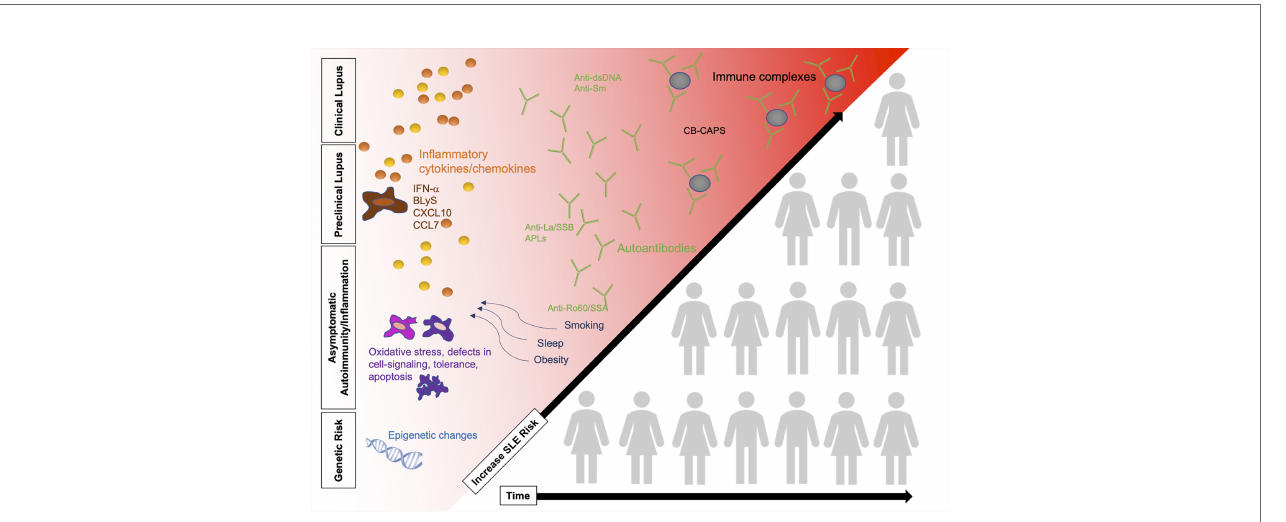
FIGURE 1 | SLE pathogenesis in four phases, increasing in SLE risk over time as patients accumulate risk factors. Changes in the immune system are detected prior to the diagnosis of clinical SLE including presence of autoantibodies, cytokines, and immune complex deposition. Some patients (illustration not representative of actual pre-clinical/clinical SLE population) will progress over time to clinical SLE while others remain in the earlier stages of preclinical SLE. Refer to Figure 2 for potential points for early risk assessment and intervention opportunities. BLyS, B-cell lymphocyte stimulator; IFN, interferon; SLE, systemic lupus